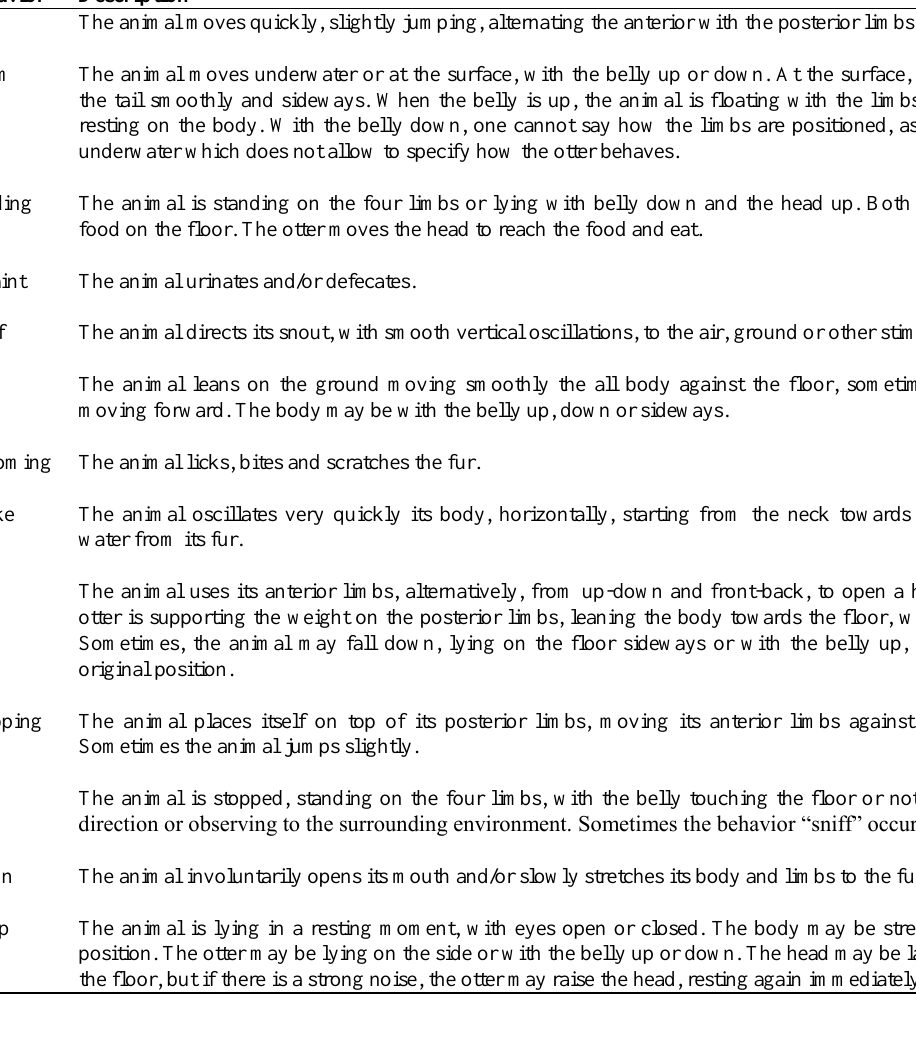
Table 1 Ethogram of the Common Otter in Captivity for the Individual Category of Behaviors Behavior